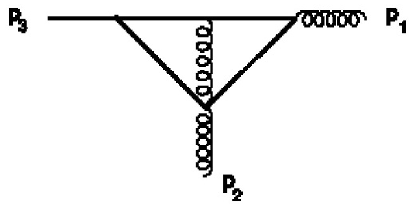
Figure 7. The planar double